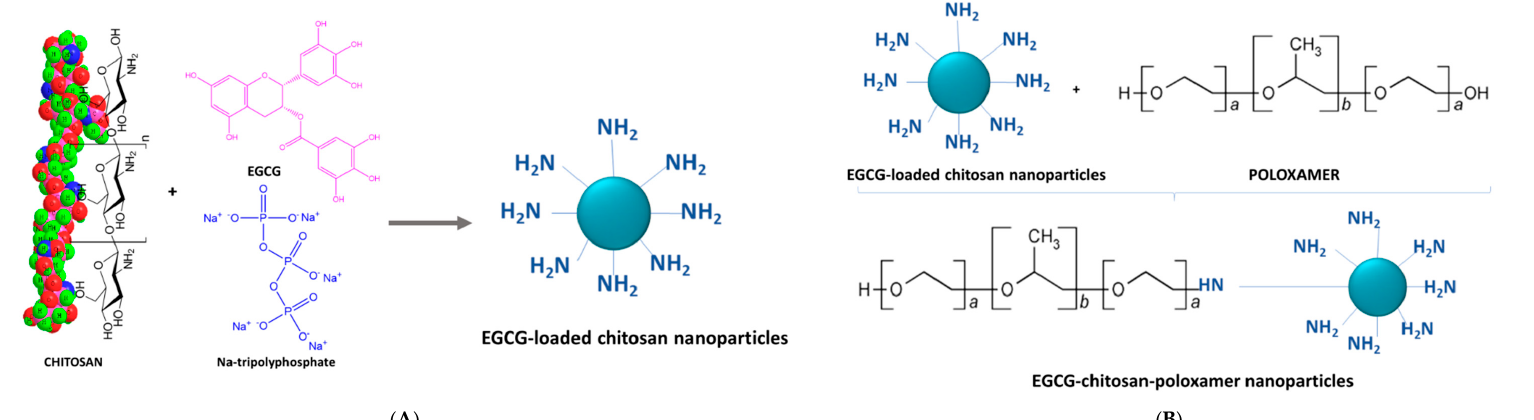
Figure 3. Synthesis mechanism of catechin-loaded keratin-based nanoparticles by: ( A ) methylene bridge formation in keratin, ( B ) catechin polymer synthesis by methyolation with formaldehyde, condensation and polymerization ( C ) electrophilic reaction of the thiol groups of keratin, with catechin quinone obtained by catechin autooxidation (Adapted from References [11,42–44]).